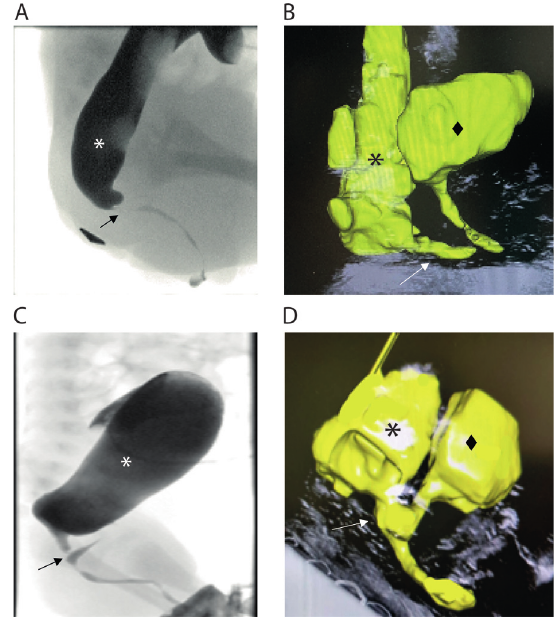
Fig. 3 Comparison between distal colostogram ( A, C ) and the automatically 3D reconstructed structures, including bladder, ure- thra, and recto-urethral fi stula, acquired from the linear ultrasound imaging ( B, D ) from the same patient. A and B show a recto-bulbar fi stula, C and D a recto-prostatic fi stula. The star indicates the rectum, the diamond shape of the bladder, and the arrow points to the recto- urethral fi stula.